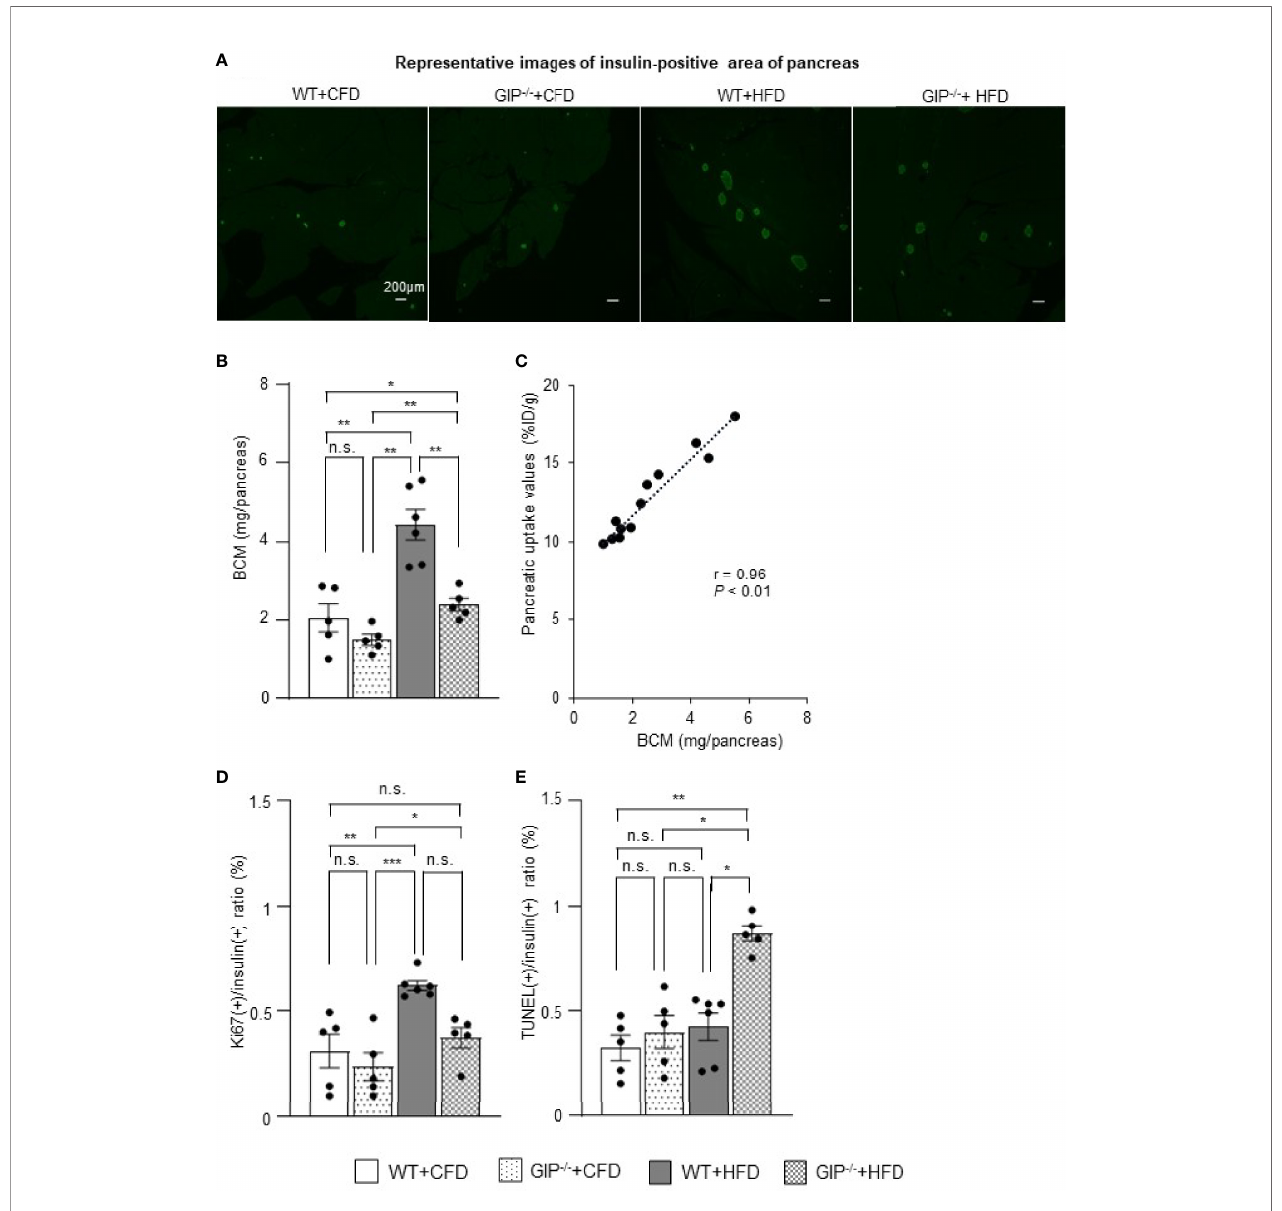
FIGURE 4 | Histological quanti fi cation of BCM and immunohistochemical analysis of proliferation and apoptosis of b -cells. (A) Representative images of insulin- positive areas of the pancreas in each group at 16 weeks of age. (B) b -cell mass (BCM) was calculated as the product of the insulin-positive ratio and the pancreatic weight. (C) Correlation between pancreatic uptake values on 111 In-exendin-4 SPECT/CT [percentage of injected dose/1g (%ID/g)] and BCM calculated by histological analysis in 16-week-old WT and GIP -/- mice (n = 12). (D) Ratio of insulin/Ki67/DAPI co-positive cells to total insulin-positive cells. (E) Ratio of insulin/ TUNEL/DAPI co-positive cells to total insulin-positive cells. WT mice fed control-fat diet (WT+CFD) are indicated by white bars with solid borders (n = 5). GIP -/- mice fed control-fat diet (GIP -/- +CFD) are indicated by dotted bars with solid borders (n = 5). WT mice fed high-fat diet (WT+HFD) are indicated by gray bars (n = 6). GIP -/- mice fed high-fat diet (GIP -/- +HFD) are indicated by checkerboard bars (n = 5). P values are expressed as follows: *P < 0.05, **P < 0.01, *** P < 0.001 (one way ANOVA with Tukey ’ s test). n.s., no statistical signi fi